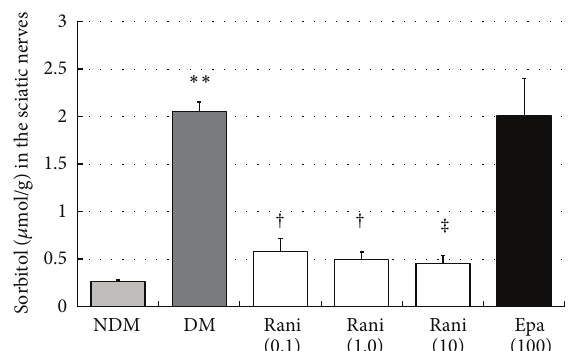
Figure 14: The fructose levels in the sciatic nerves at 40 weeks. The fructose levels in the sciatic nerves in the untreated SDT rats are significantly higher in the SD rats. ∗∗ 𝑃 < 0.01 , Student’s 𝑡 -test. The fructoselevels in thesciaticnerves treated with all doses ofranirestat are significantly lower than in the untreated SDT rats. † 𝑃 < 0.05 and ‡ 𝑃 < 0.01 , Dunnett type joint-ranking test. Epalrestat does not affect the reduced fructose levels. NDM: non-diabetes mellitus; DM: diabetes mellitus; rani: ranirestat; epal: